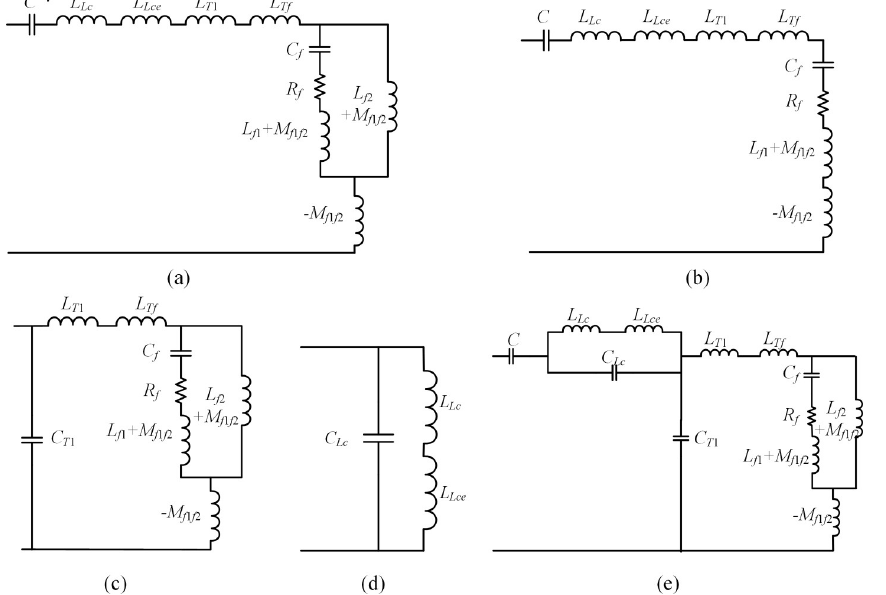
Fig 5. Resonant circuits of the CVT with a resonant-type damper. (a) Resonant circuit 1. (b) Resonant circuit 2. (c) Resonant circuit 3. (d) Resonant circuit 4. (e) Resonant circuit 5.